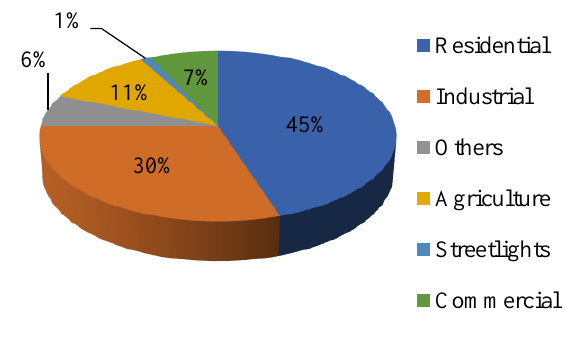
Fig. 4. Electricity consumption by sectors in Pakistan